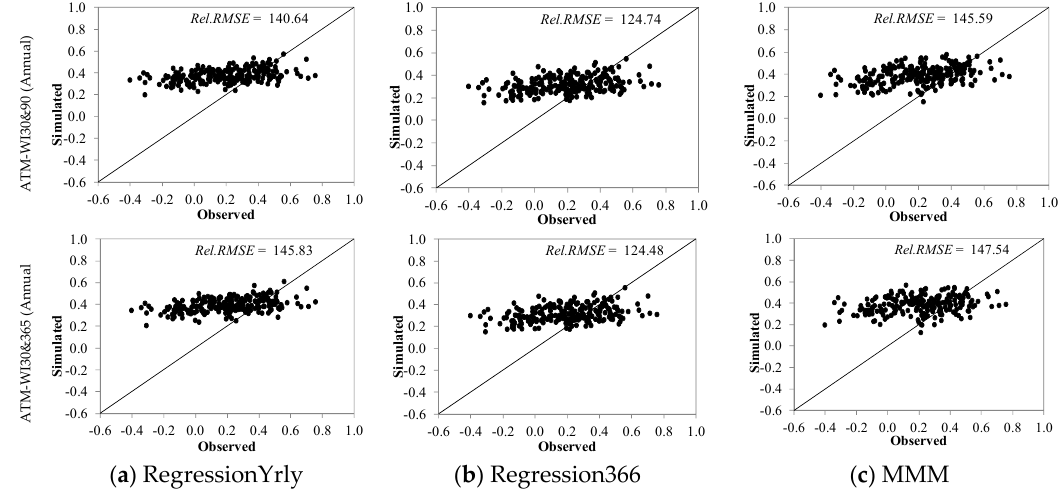
Figure 10. Scatter plots of observed and models simulated daily, monthly and annual cross correlations using multisite model (Validation period). Rel. RMSE values are shown on the top right of each plot: ( a ) using RegressionYrly model; ( b ) using Regression366 model; and ( c ) using MMM.